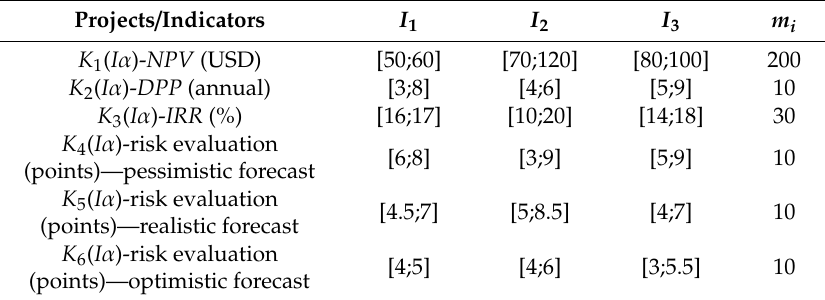
Table 3. Data implication for di ff erent